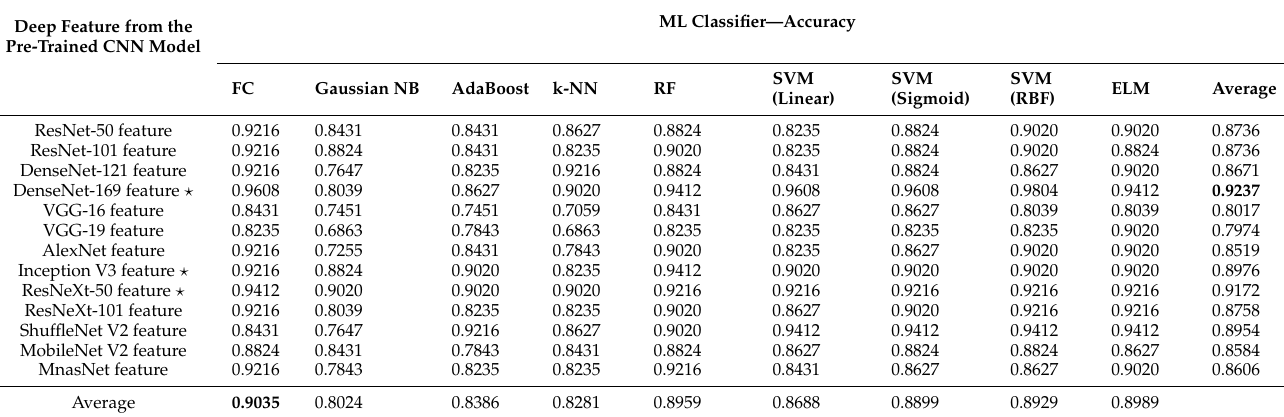
The bold text represents the highest average accuracy of all ML classifier or all deep